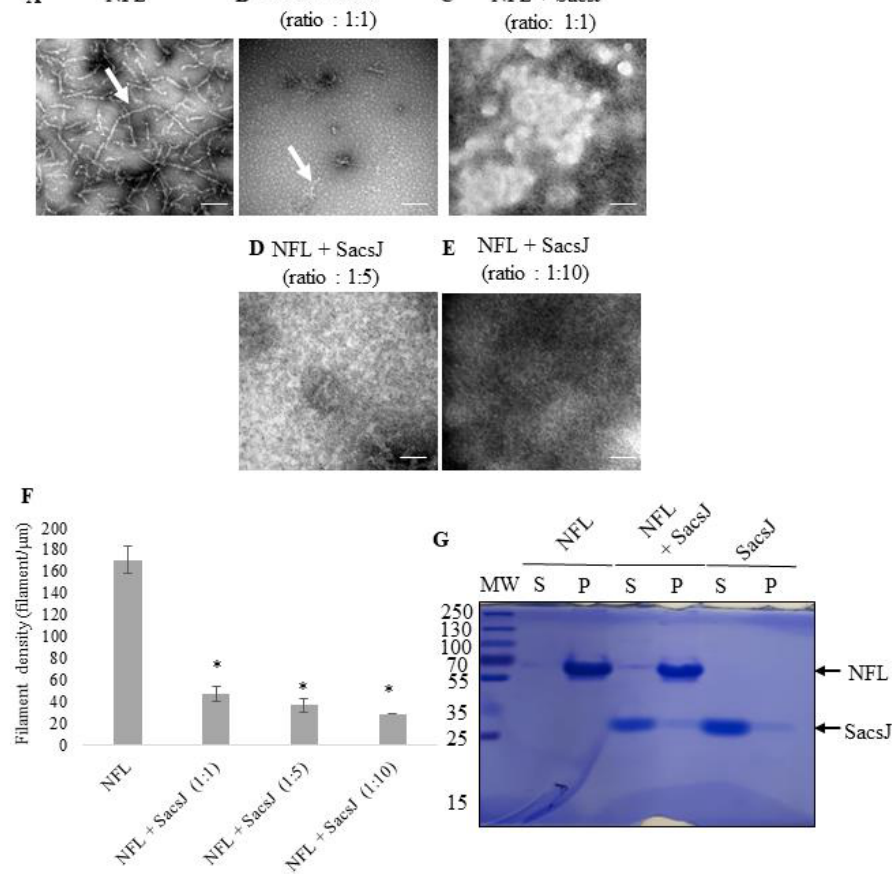
Figure 2. SacsJ impaired NFL assembly in vitro. ( A – E ) TEM of negatively stained preparations of assembled NFL dialyzed alone ( A ) or in the presence of different molar ratios of NFL to GST-SacsJ: 1:1 ( B , C ), 1:5 ( D ), and 1:10 ( E ). Scale bars: 100 nm. SacsJ prevented formation of NFL filaments (arrow). ( F ) Quantitation of NFL filament density: Incubation with GST-SacsJ significantly reduced filament density in a concentration-dependent fashion (filaments/ µ m 2 ). * p < 0.05 vs. NFL alone, one-way ANOVA ( n = 3). ( G ) SDS-PAGE of an in vitro sedimentation assay of NFL with or without SacsJ after assembly at 4 °C overnight at NFL:SacsJ ratio of 1:6. The supernatant (S) and pellet (P) fractions were analyzed by SDS-PAGE followed by Coomassie Blue staining. NFL and SacsJ bands are indicated by arrows and molecular weight is on the left.